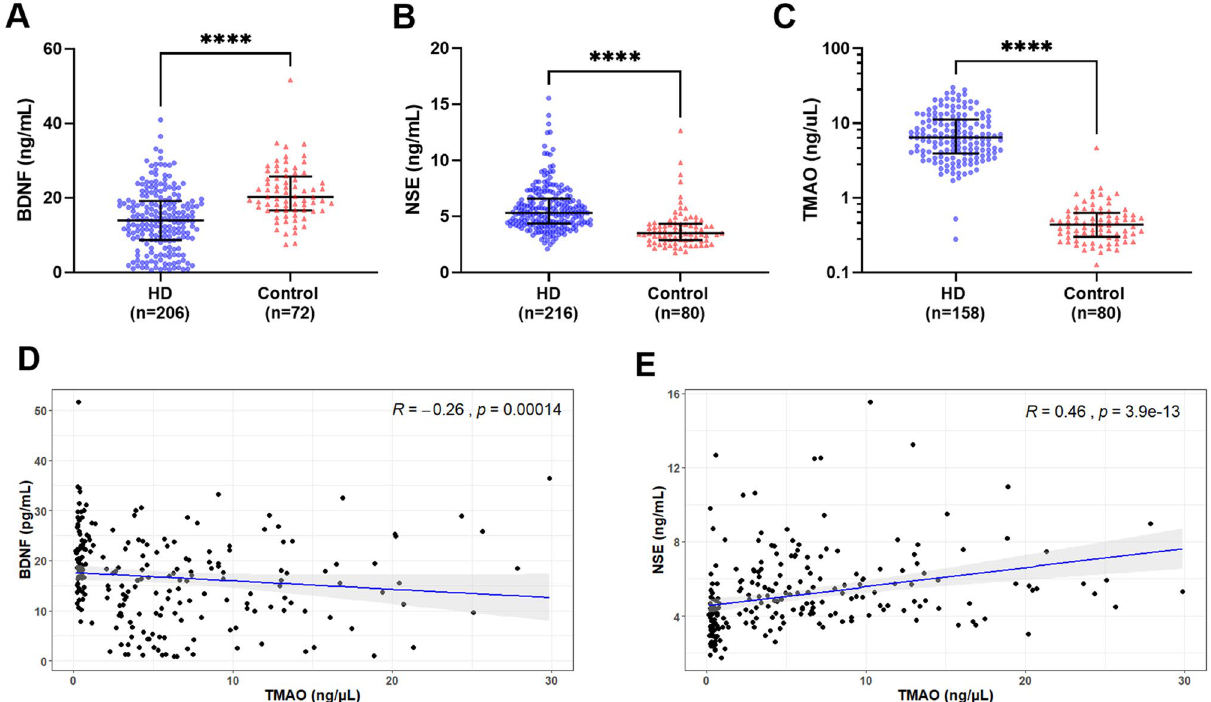
Figure 1. Analysis of serum biomarkers in haemodialysis (HD) and non-CKD controls (control). ( A ) Brain-derived neurotrophic factor (BDNF), ( B ) Neuron-specific enolase (NSE) were measured by enzyme- linked immunosorbent assay (ELISA). ( C ) Trimethylamine N-oxide (TMAO) was measured by liquid chromatography-mass spectrometry (LC–MS). The number of samples (n) that each analyte was detected in is noted for each group. Data presented at median and interquartile range. Statistical significance, *** p < 0.001, **** p < 0.0001. ( D ) Spearman’s correlation between BDNF and TMAO levels. ( E ) Spearman’s correlation between NSE and TMAO levels.